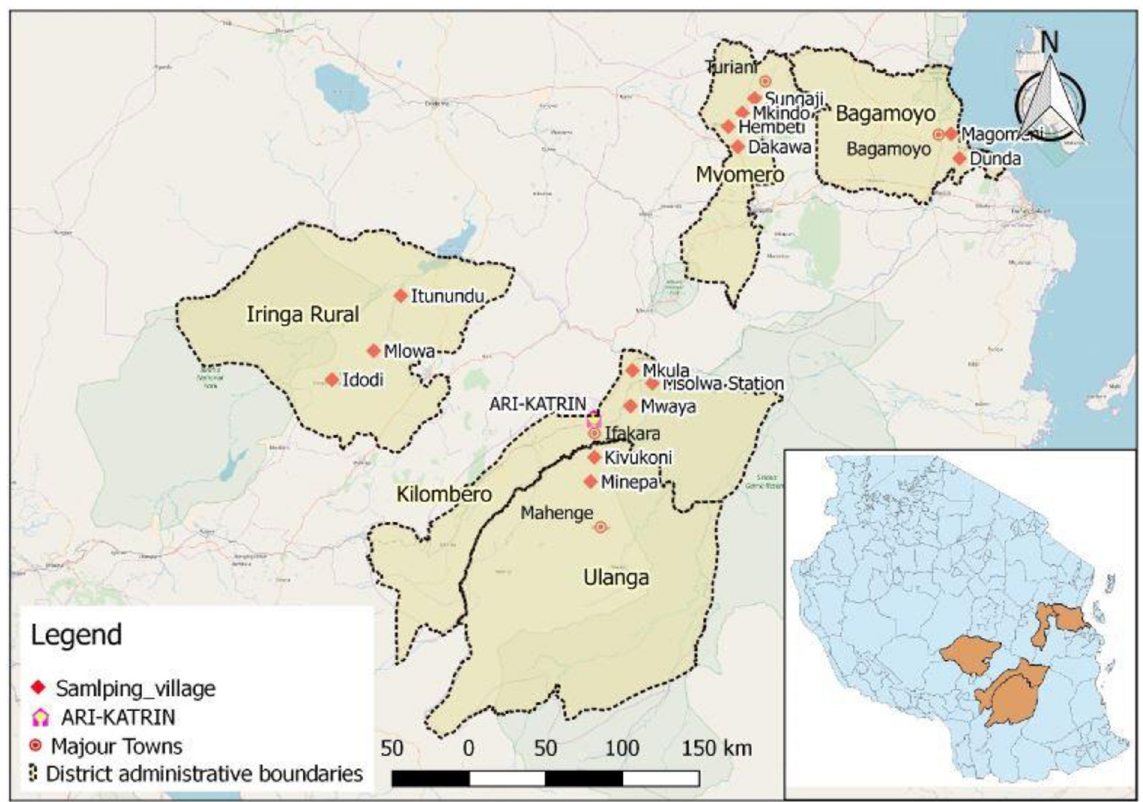
Fig 2. Study area surveyed for pepeta product and its indigenous processing knowledge in Tanzania. Coordinates for district administrative boundaries are indicated as follows: Kilombero (08 o 07’S, 36 o 40’E), Ulanga (09 o 00’S, 36 o 40’E), Mvomero (06 o 18’S, 37 o 27’E), Bagamoyo (06 o 26’S, 38 o 54’E) and Iringa rural (07 o 46’S, 35 o 42’E). ARI-KATRIN = Agricultural Research Institute KATRIN. Source: Survey data, September 2017 – February 2018. The map background and shapefiles were taken from OpenStreetMap Foundation (OSMF, United Kingdom) and National Bureau of Statistics (NBS, Tanzania) with permission under a CC BY license,